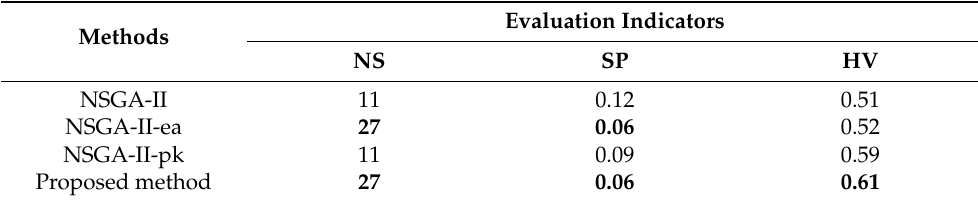
Table 2. Performance comparison of different